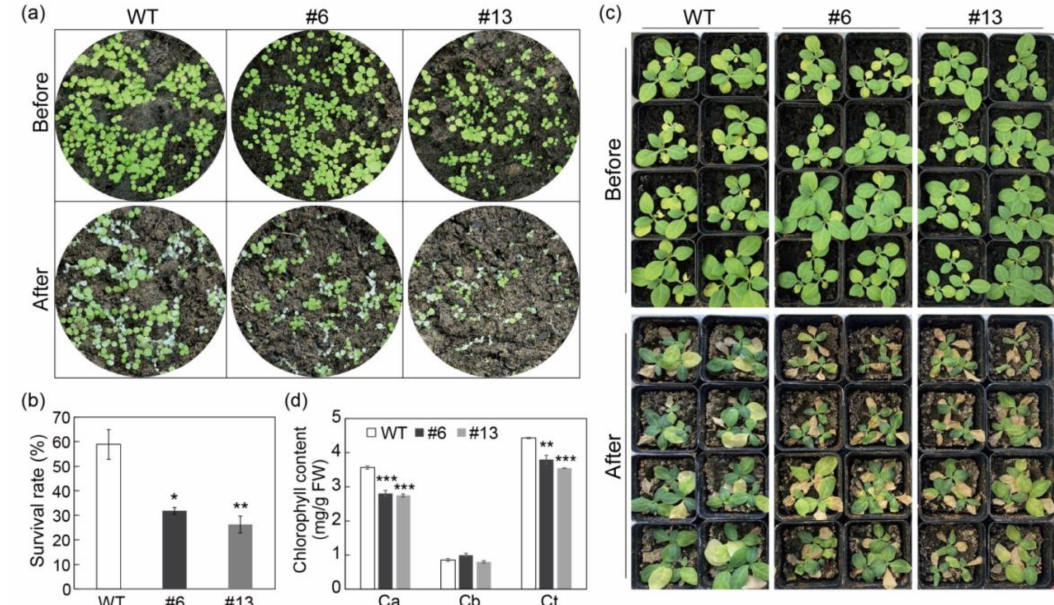
Figure 5. Salt tolerance assays of transgenic tobacco plants overexpressing PtrMYB3. ( a ) Representative images of 7-day-old tobacco plants of the two transgenic lines (#6 and #13) and wild-type (WT) before and after salt treatment. ( b ) The survival rate of the two transgenic lines and WT after salt treatment. ( c ) Representative images of 40-day-old tobacco plants of the two transgenic lines and WT before and after salt treatment. ( d ) The chlorophyll content (a, b and total) of the two transgenic lines and WT after salt treatment. Ca: chlorophyll a; Cb: chlorophyll b; Ct: total chlorophyll including a and b. Error bars indicate ± SE. Asterisks indicate significant differences between the transgenic line and WT: p < 0.05 (*), p < 0.01 (**) and p < 0.001